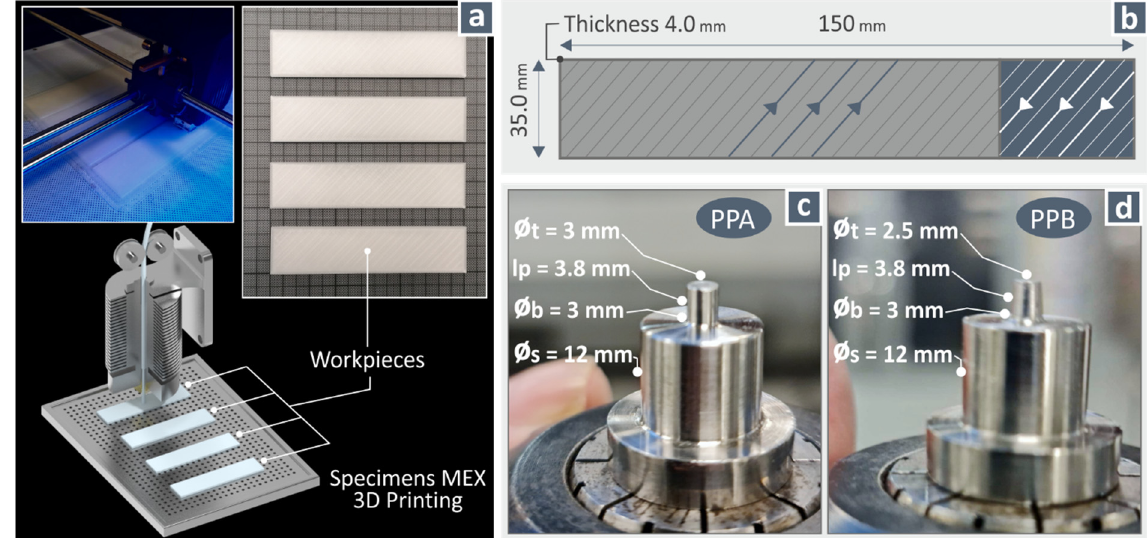
Figure 1. ( a ) MEX 3D-printed specimens for the FSW process; ( b ) specimen dimensions and infill pattern (lines and arrows indicating the specimen’s 3D-printed structure); ( c ) Welding Tool A (PPA) dimensions; ( d ) Welding Tool B (PPB) dimensions.